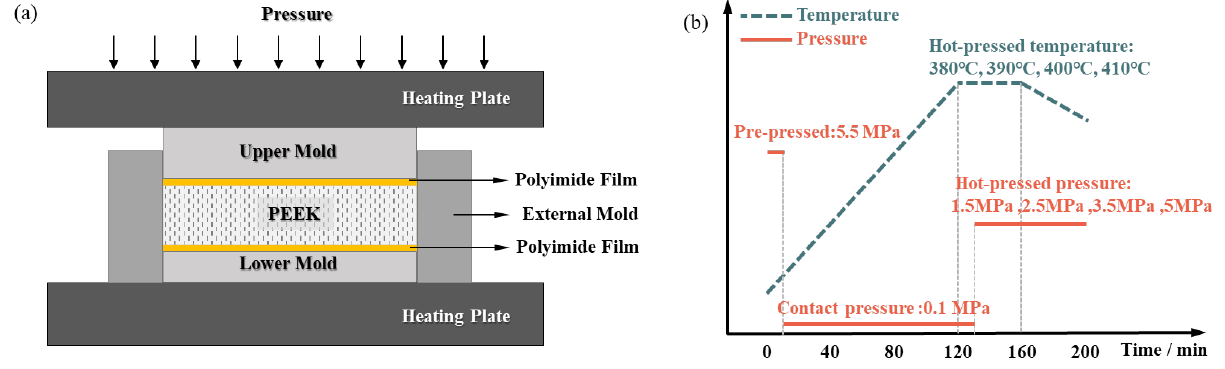
Figure 1. Hot compression method for PEEK. ( a ) Hot compression device schematic. ( b ) Schematic diagram of parameter setting for PEEK sheet preparation